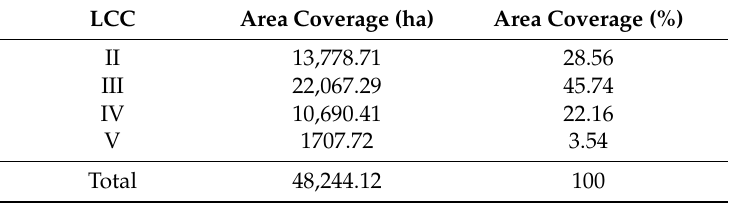
Table 6. Area coverage land capability classes (LCCs) among the ACZs of the study site.